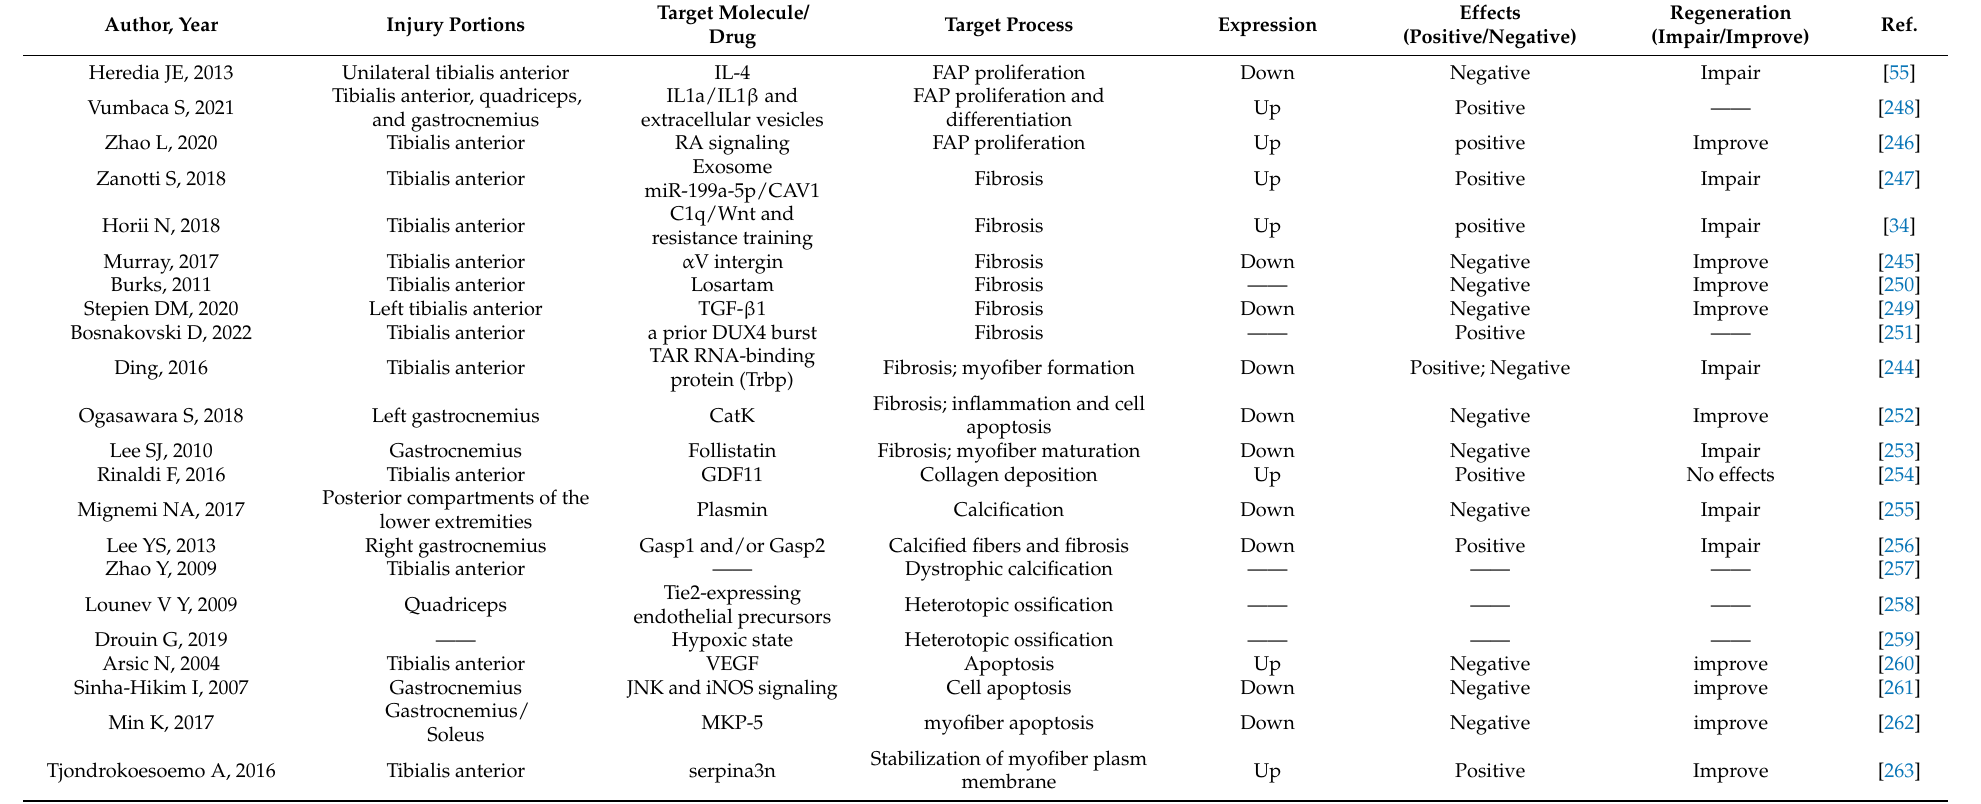
Table 4. Fibrosis, calcification, and